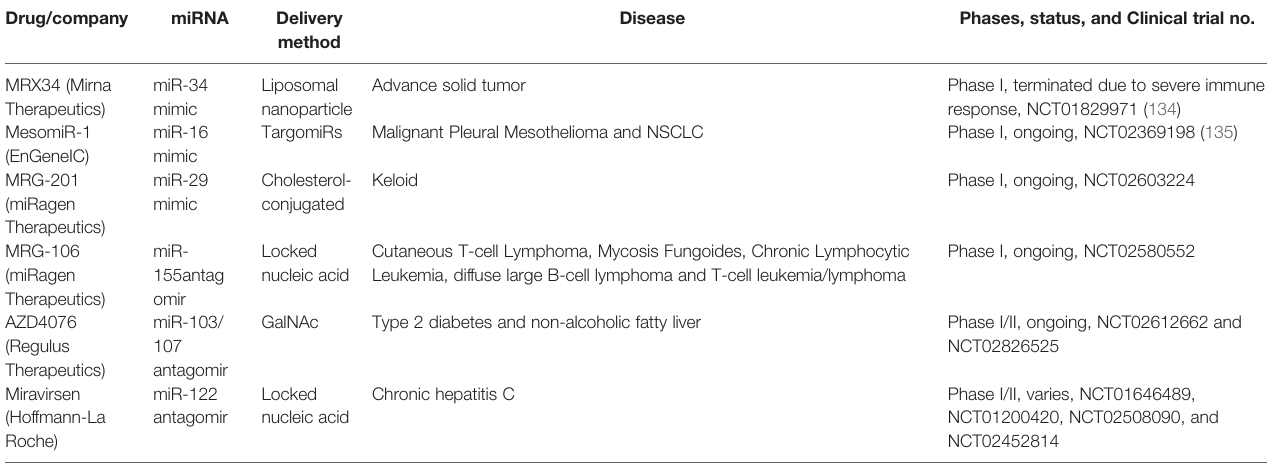
TABLE 2 | Summary of miRNAs drugs FDR-approved in clinical